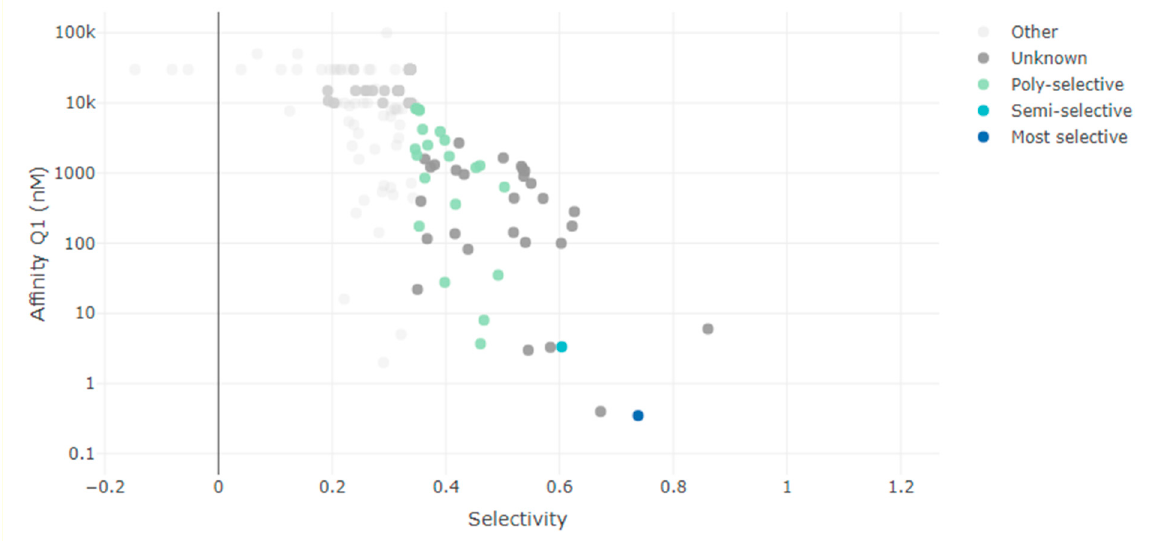
Figure 3. The graph from the small molecular suite showing the most selective, semi-selective and poly-selective molecules that are a hit against the HCK gene. (10k = 10,000, 100k = 100,000).